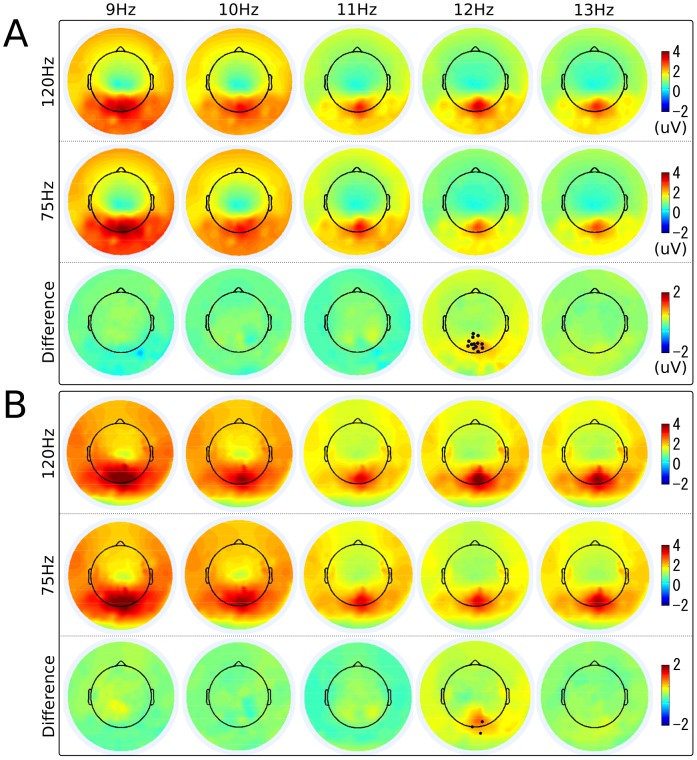
Scalp topographies of amplitude and SNR of SSVEPs under 75 Hz and 120 Hz refresh rates.Scalp topographies of (A) the amplitudes and (B) the SNRs of SSVEPs at each stimulation frequency under the 120 Hz (top) and 75 Hz (middle) refresh rate, and their difference (bottom). The electrodes with significantly different amplitudes elicited by two different refresh rates are marked with black dots (p<10−4).